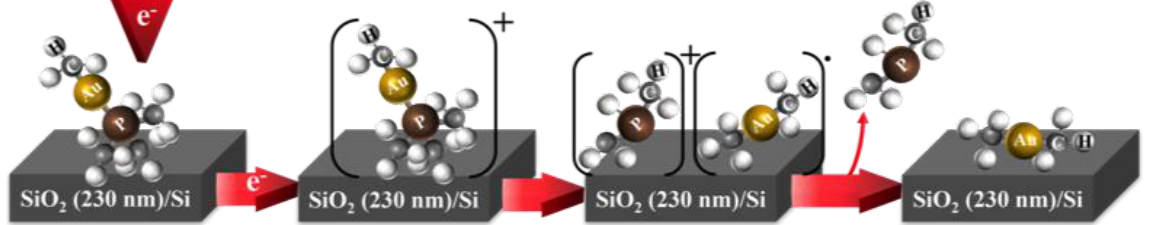
Figure 6. Proposed deposition scheme for the reaction steps of (CH 3 )Au(CH 3 ) 3 in the UHV FEBID. After electron-induced ionization of (CH 3 )AuP(CH 3 ) 3 , a positively charged short-lived ion is produced [(CH 3 )Au(CH 3 ) 3 ] + and fragments to form [P(CH n ) 2 ] + and [(CH 3 ) 2 Au]. In the last step, [P(CH n ) 2 ] desorbs from the surface, and [(CH 3 ) 2 Au] · stays as a deposited fragment.